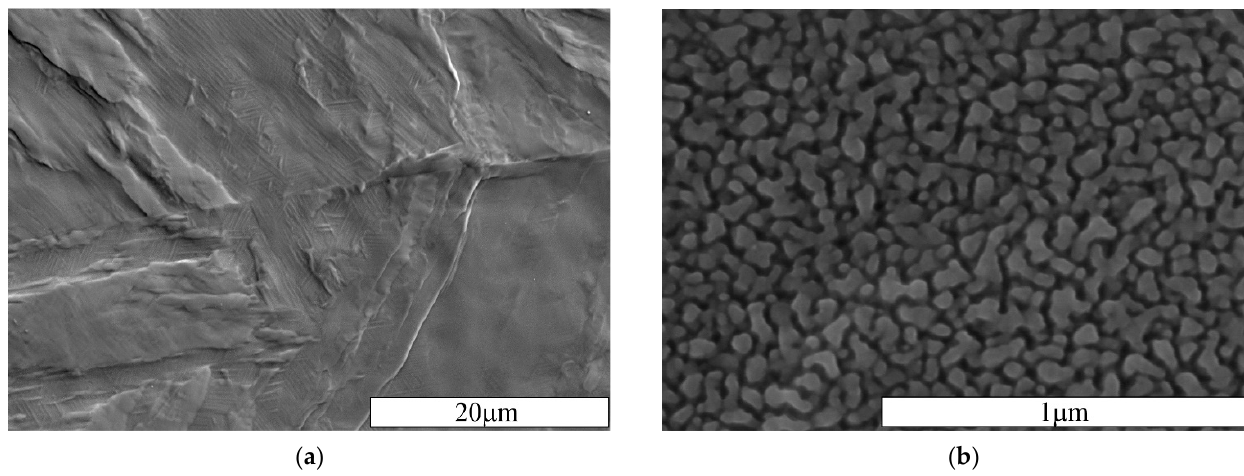
Figure 6. Secondary electron images of the surface of the nitrided layer at a temperature of 425 °C for 4 h in an atmosphere containing 20% NH 3 ; ( a ) surface relief, ( b ) surface nitrides